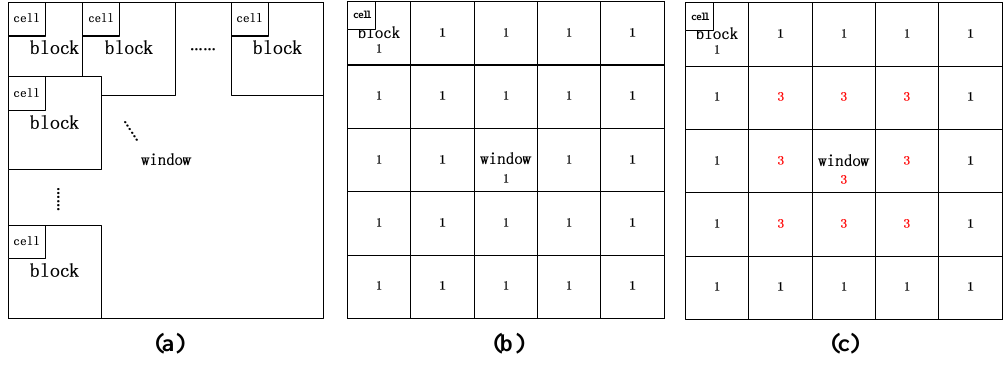
Figure 4. Original Histogram of Oriented Gradient (HOG) algorithm and improved HOG algorithm. ( a ) Original HOG algorithm; ( b ) Weights of blocks in the original HOG algorithm; ( c ) Weights of blocks in the improved HOG